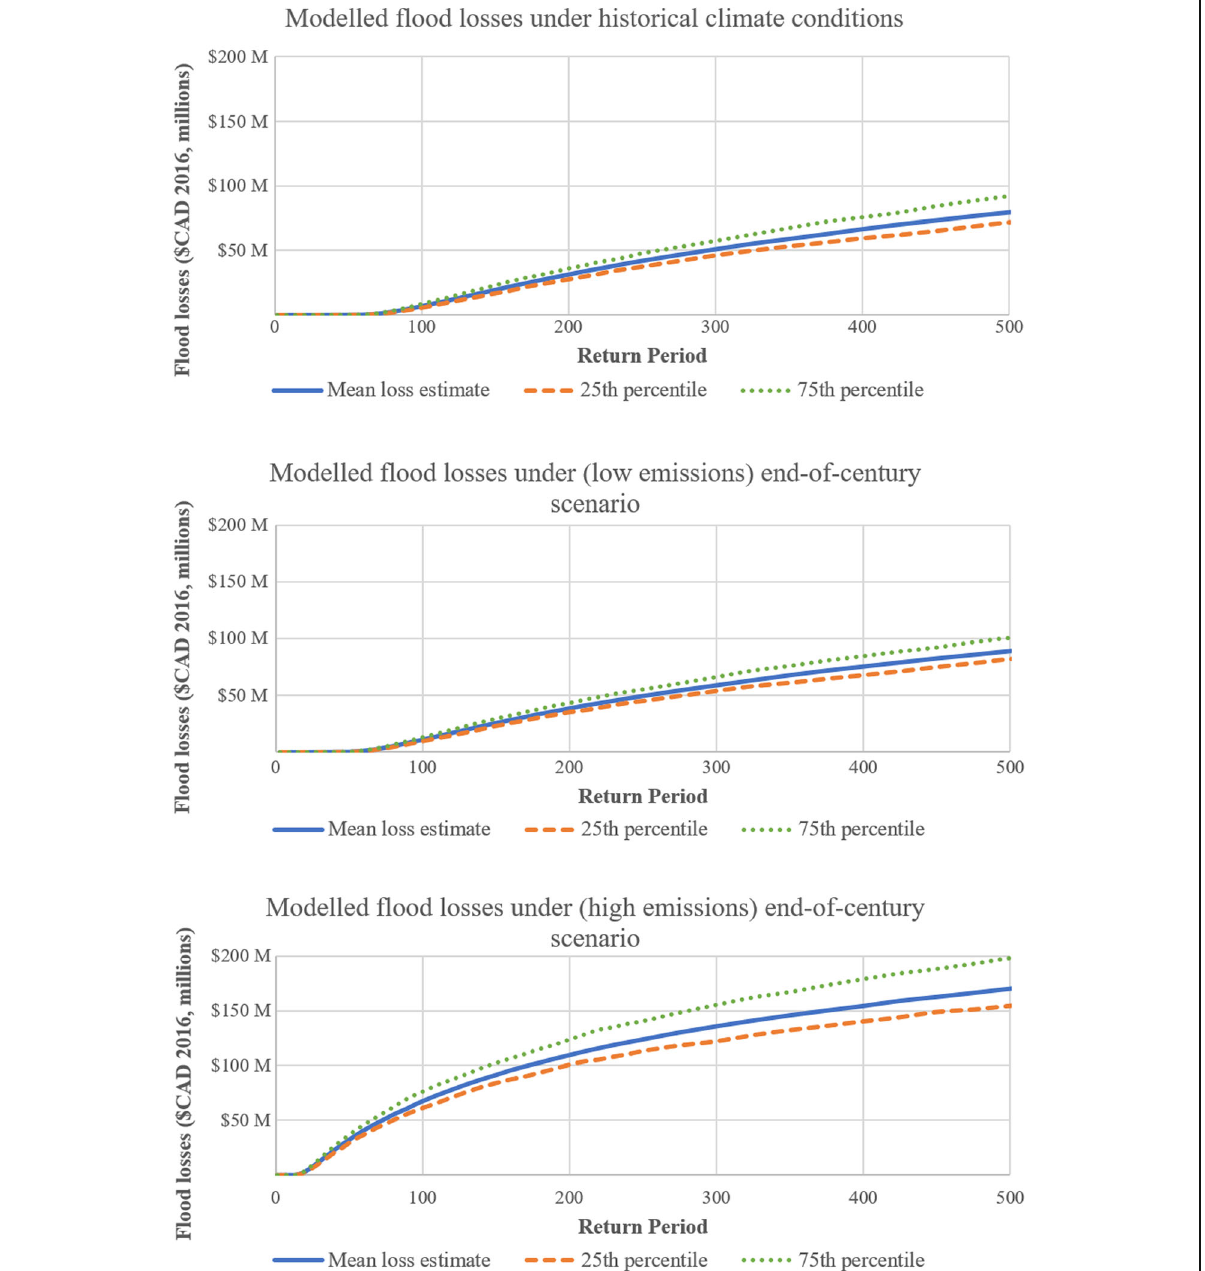
Fig. 3 Changes in flood losses for all modelled flood events. Uncertainty in model results is represented using the 25th and 75th percentiles of loss around the EP curve (illustrated using dotted lines), computed on a per event basis (see Cleveland 2015; Foote et al.